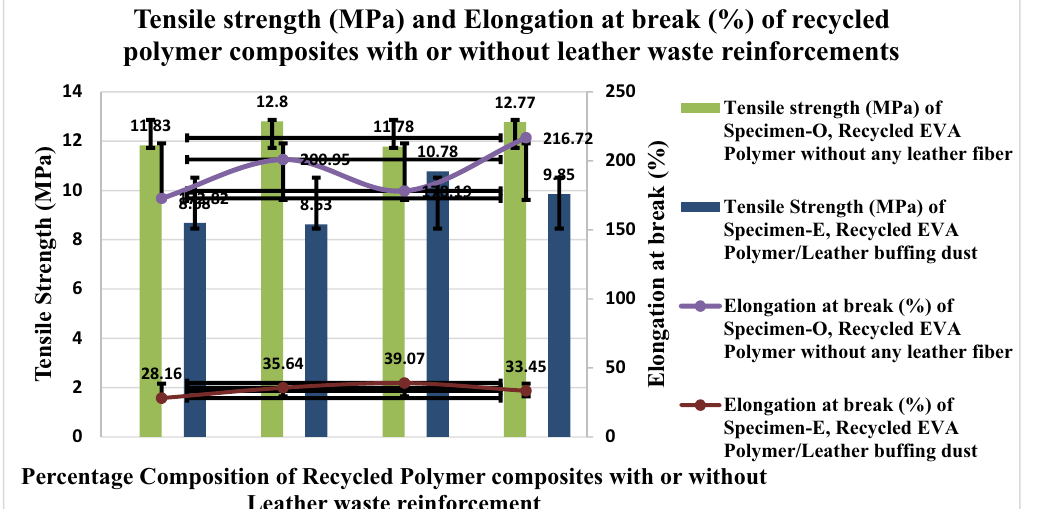
Figure 30: comparison of the tensile strength of neat recycled EVA polymer composites and leather bu ffi ng dust/recycled EVA polymer composites.